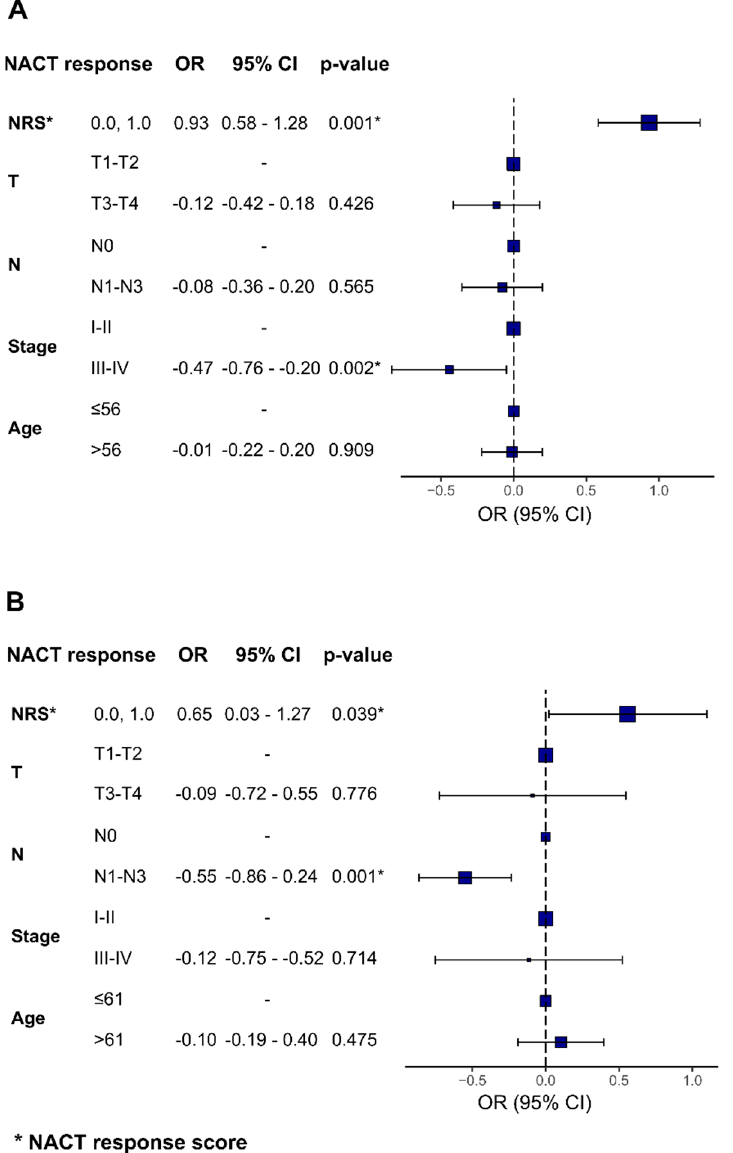
Figure 7. Forest plots indicating the odds ratios for TN tumors’ ( A ) and luminal B tumors’ ( B ) NACT response and the corresponding confidence intervals. The higher the odds ratio for NRS, the more likely the patient will demonstrate a positive response to therapy.